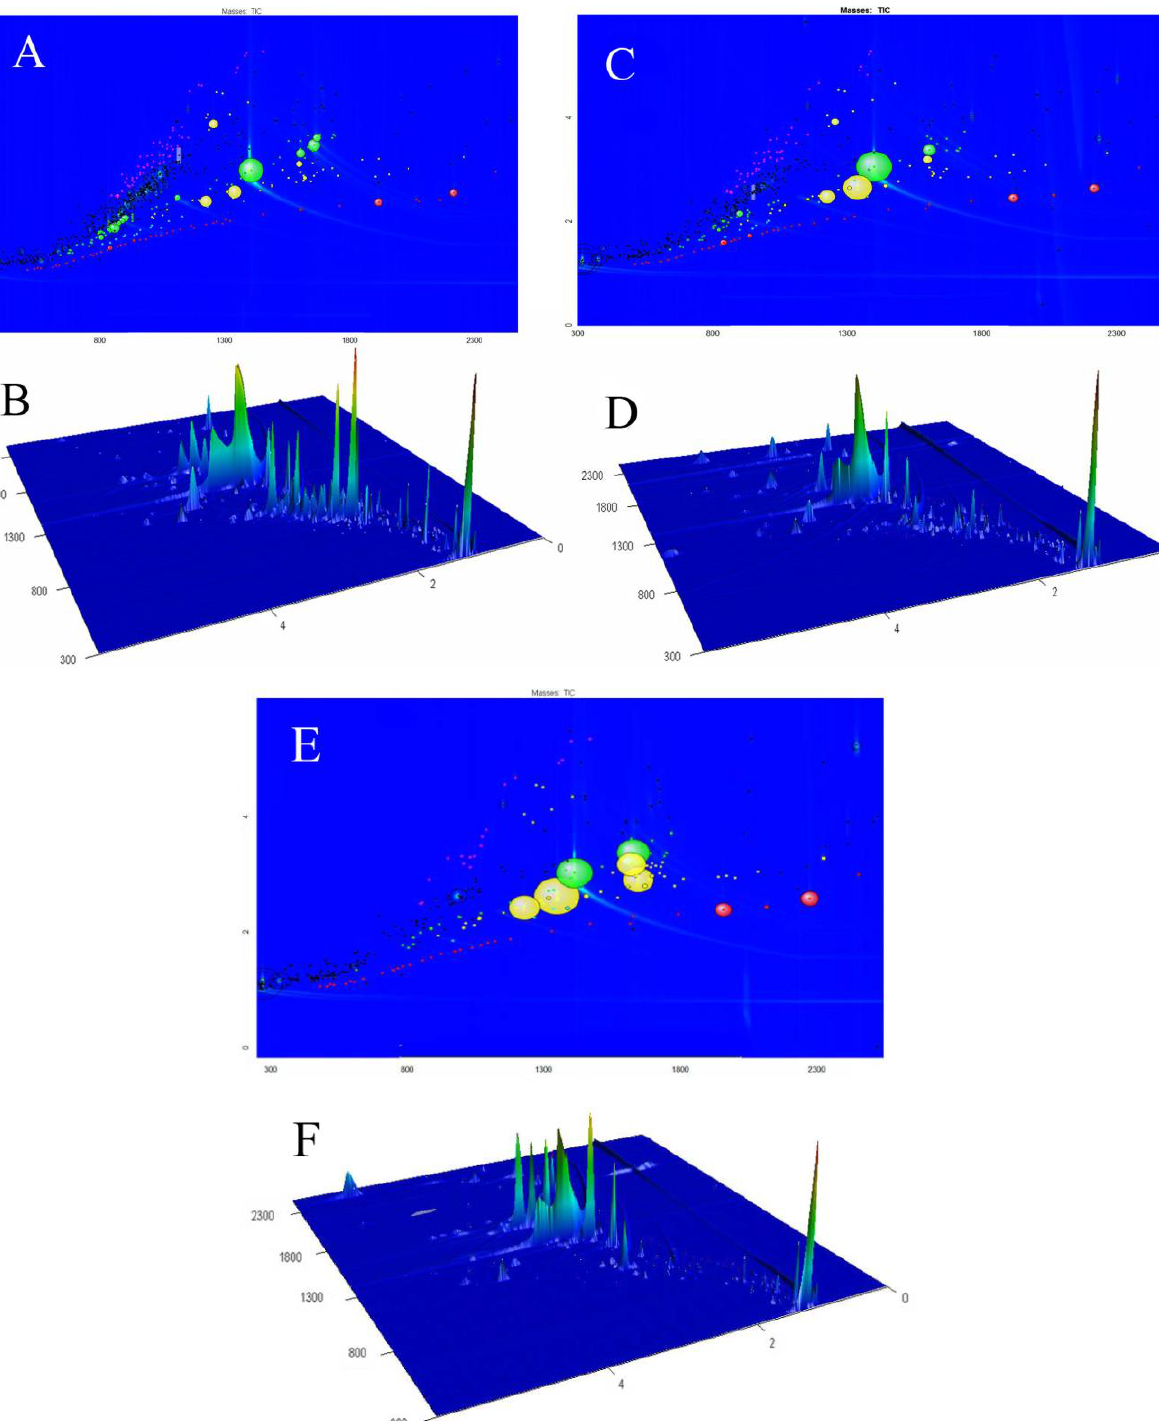
Figure 1. GC×GC-TOF/MS contour plots and three-dimensional chromatograms of non-fumigated ( A / B ), lab-prepared sulfur-fumigated ( C / D ) and industrial sulfur-fumigated (E/F) Flos Lonicerae Japonicae volatile oils. Peak identification information is provided